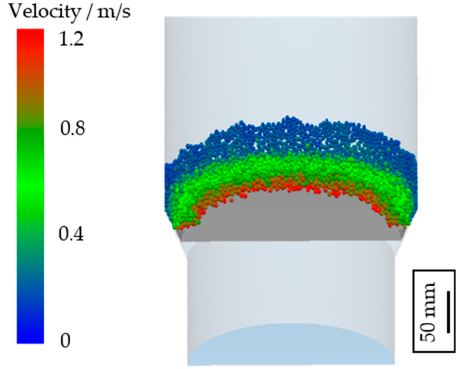
Figure 4. Particles colored by velocity magnitude for the dry case after 60 s.